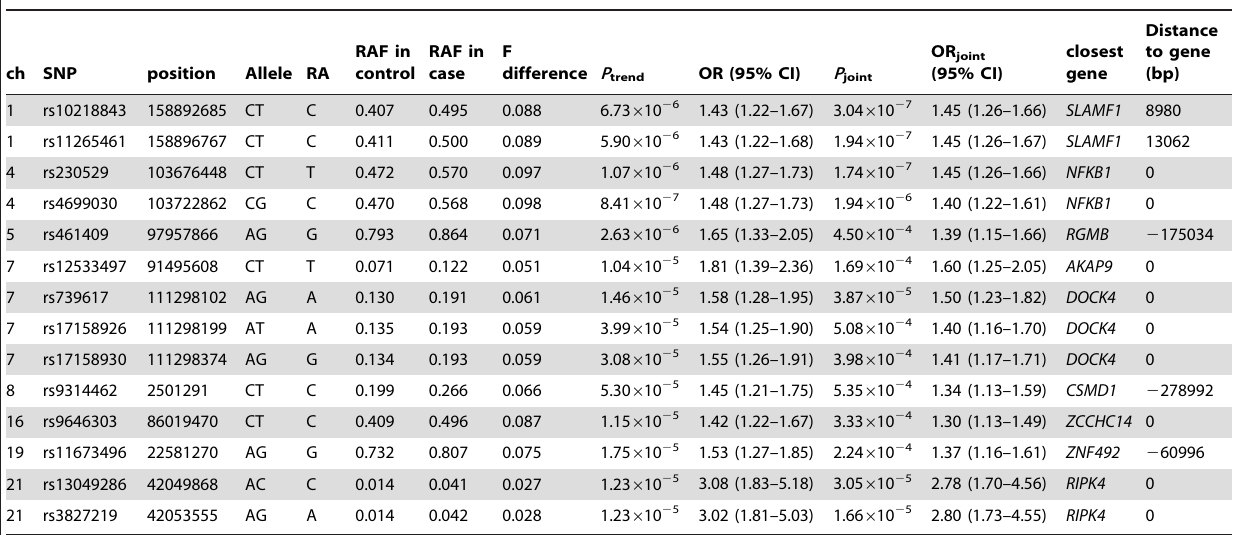
SNP position were indexed to the forward of NCBI Build 36.3. ch: chromosome. RA: Risk allele, the allele with higher frequency in schizophrenia as compared with controls; RAF: risk allele frequency. F: frequency. P trend : P values obtained from the initial GWA analysis on 522 cases and 806 controls. P joint : P values calculated from joint analysis on 804 cases and 806 controls. OR, odds ratio for risk allele.